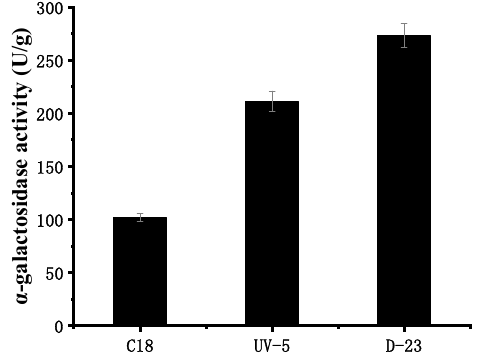
Figure 1. The α -galactosidase activity of various mutagenic strains (C18: Initial strain; UV-5: Ultra- violet mutagenic strain; D-23: Chemical mutagenic strain).